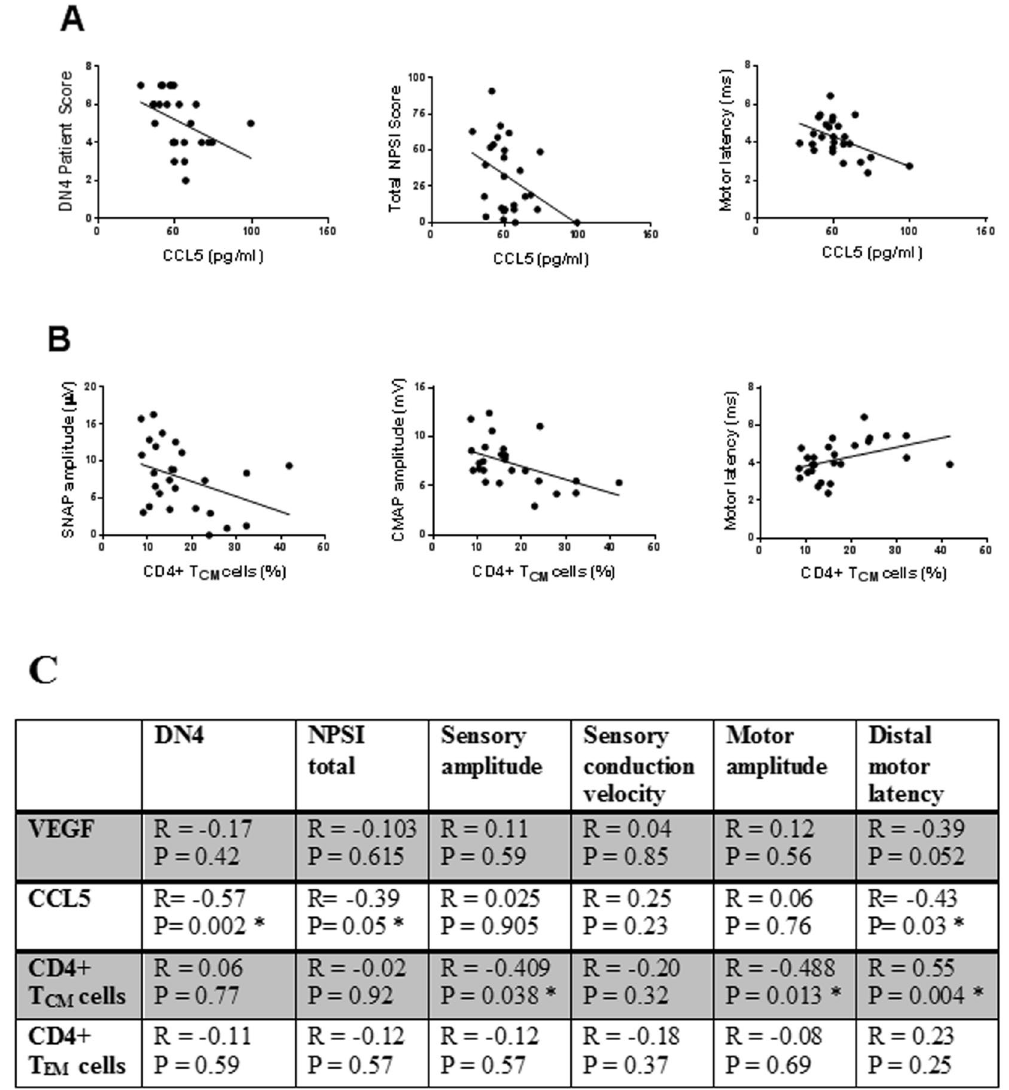
Figure 5. Correlations between immune markers, neuropathic pain scores, and neurophysiological parameters. ( A ) Serum CCL5 is inversly correlated with the neuropathic pain scores of DN4 and total NPSI, and with distal motor latency. ( B ) The percentage of central memory CD4 + T cells (T CM ) is inversly correlated with the SNAP and CMAP amplitudes, and positively correlated with the distal motor latency. Spearman’s rank correlation coefficient was used for analysis. ( C ) A summary of Spearman correlation coefficients (P-values) of VEGF, CCL5, and memory T (T CM and T EM ) cells with patient’s neuropathic pain symptoms and neurophysiological parameters. * Denotes significant correlation